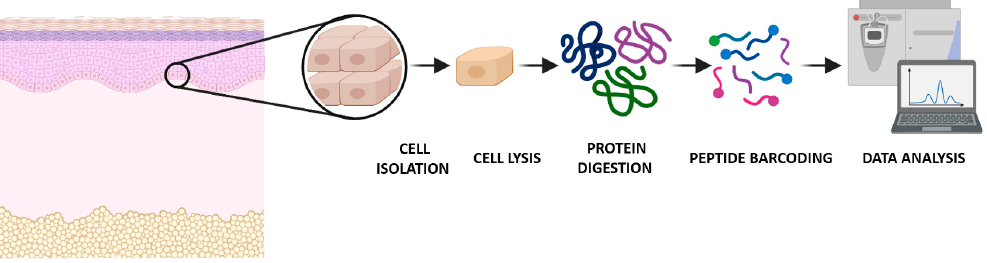
Figure 1. Global overview of the single-cell proteomics workflow analyzed by mass spectrometry.